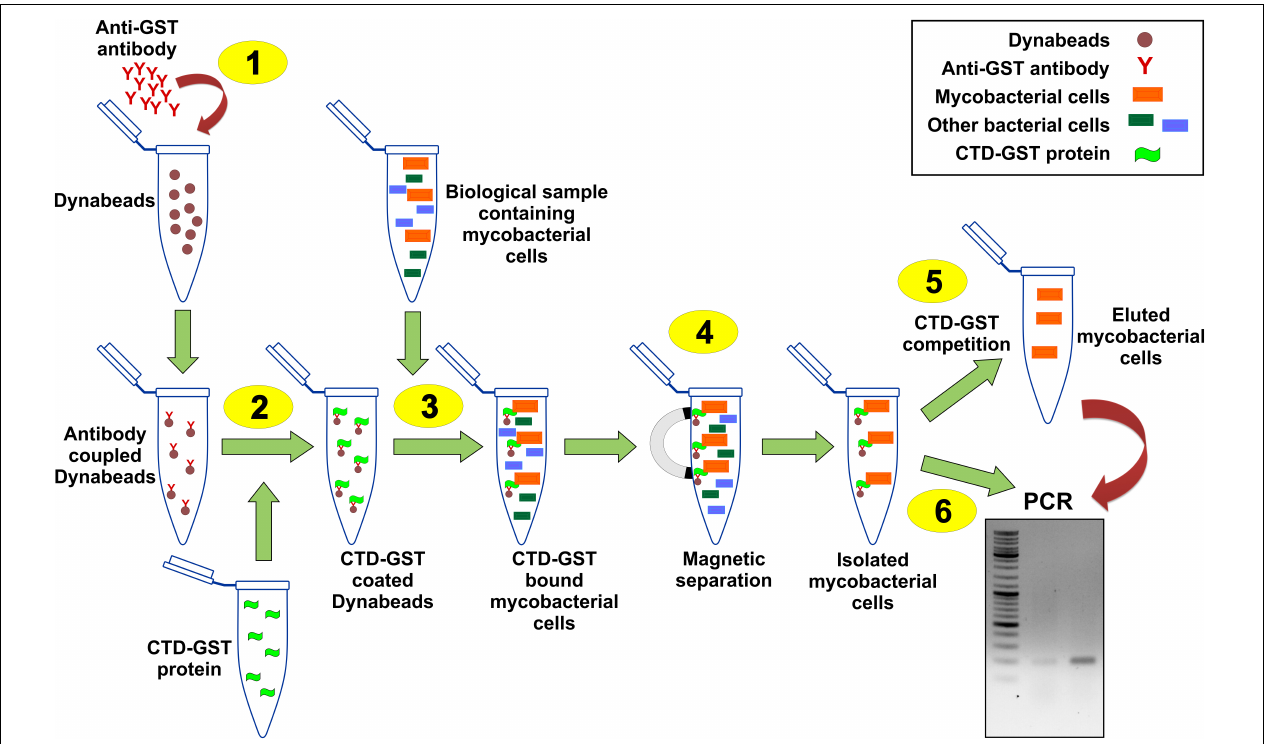
FIGURE 3 | Schematic of CTD-based mycobacterial detection assay. Illustration here shows the general procedure for the isolation of M. smegmatis cells present in a given biological sample. 1–6 represent the key steps in the assay as detailed in “Methods” section. Step 1 is the coupling of anti-GST antibodies with Dynabeads. CTD-GST protein is then coated on these beads (Step 2). Step 3 involves the incubation of mixed bacterial sample having M. smegmatis cells with the product of step 2. Step 4 involves magnetic separation of the Dynabeads that pulls down M. smegmatis cells. The isolated cells can either be eluted by competition with CTD-GST (Step 5) or be used directly in a PCR (Step